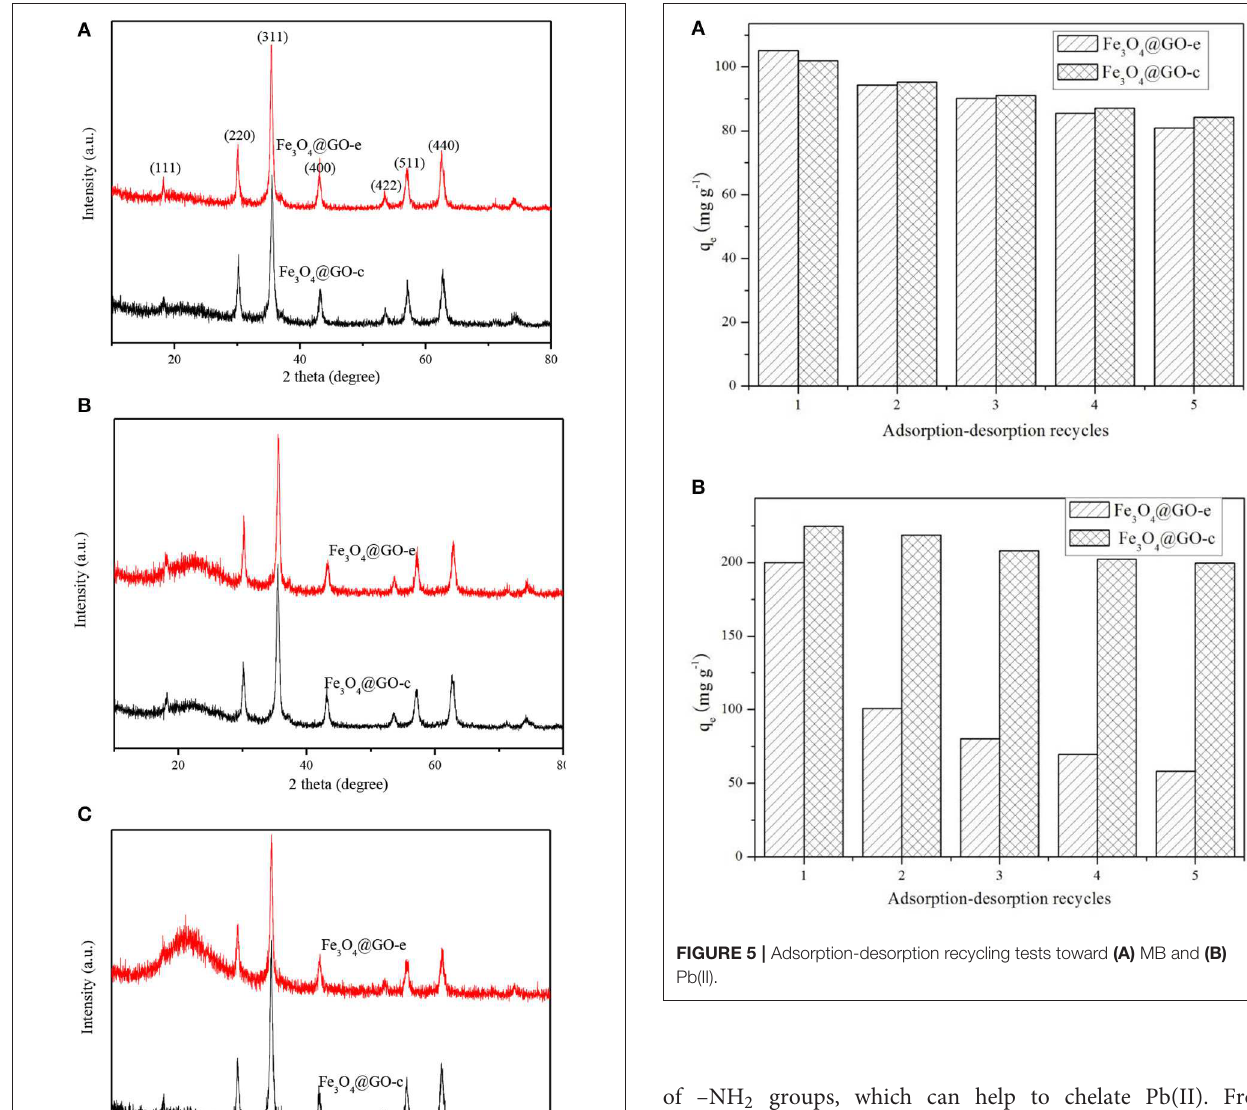
of –NH 2 groups, which can help to chelate Pb(II).